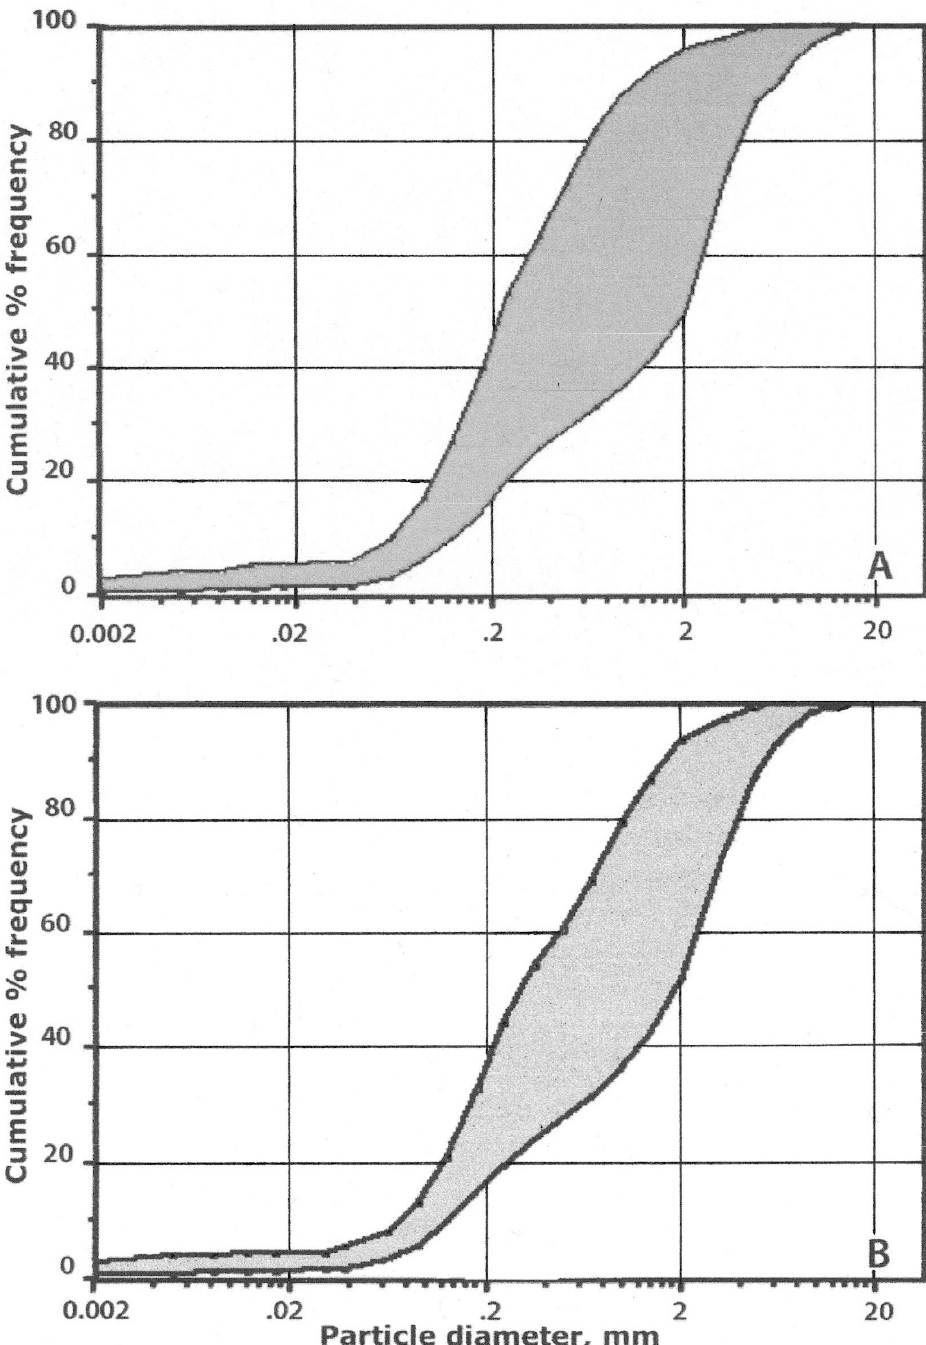
Figure 7. Particle-size distributions, grain diameter (mm) for surface (0–10 cm depth) soils. Each graphic envelope indicates textural variation for 20 whole samples—soil and gravel fractions combined. ( A ) Soils under LIs, below k ū paoa canopy. ( B ) Adjacent bare soils (control).